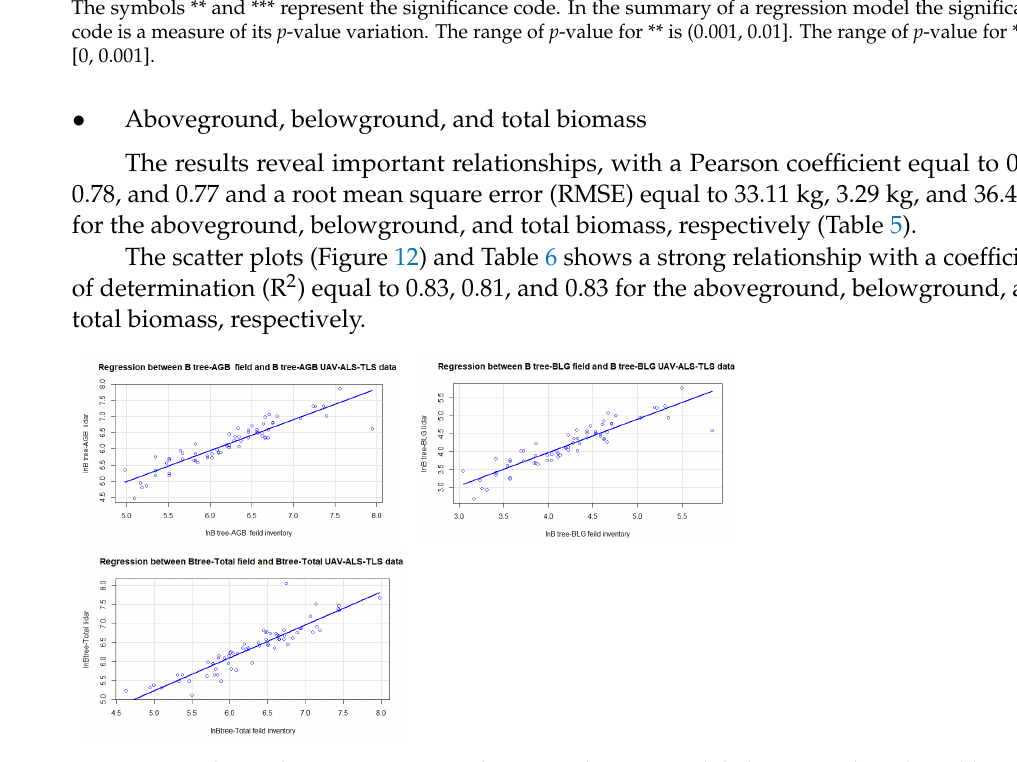
Figure 12. Relationship Representation between aboveground, belowground, and total biomass calculated with two types of inputs (forest parameters from field measurements and those ex- tracted from UAV-ALS and TLS data), using linear regression with logarithmic